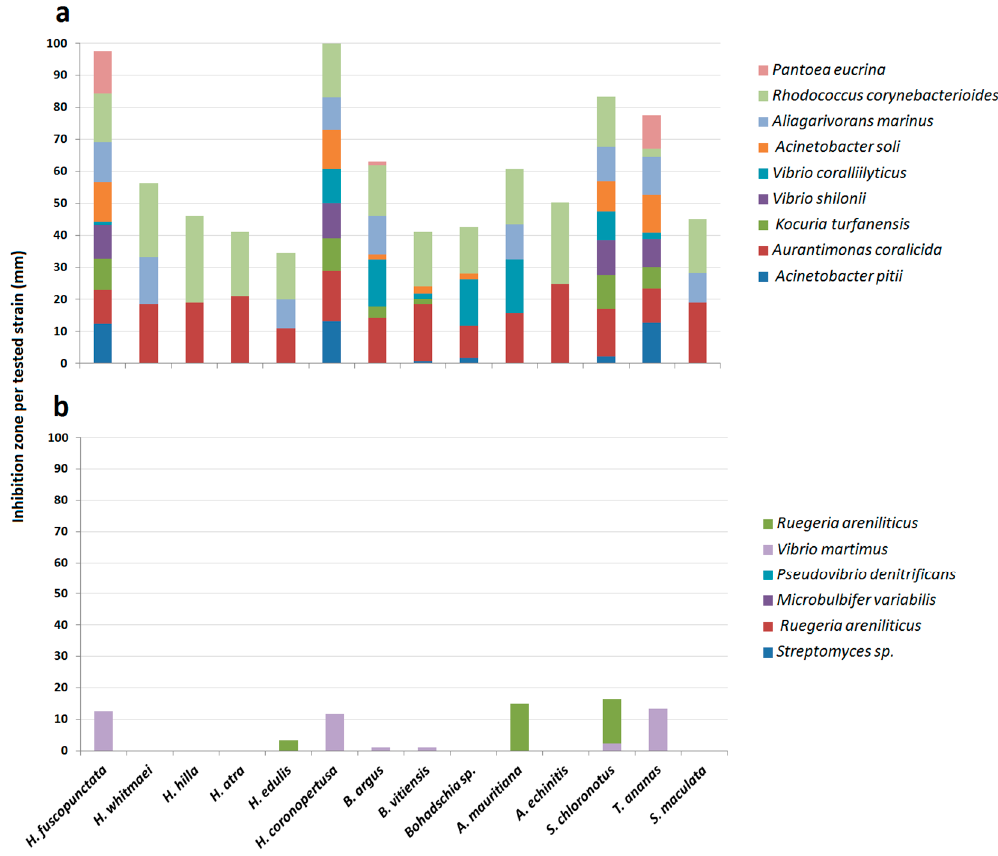
Figure 5. Total antibacterial activities of sea cucumber crude extracts against pathogenic ( a ) and non-pathogenic ( b ) environmental bacteria.